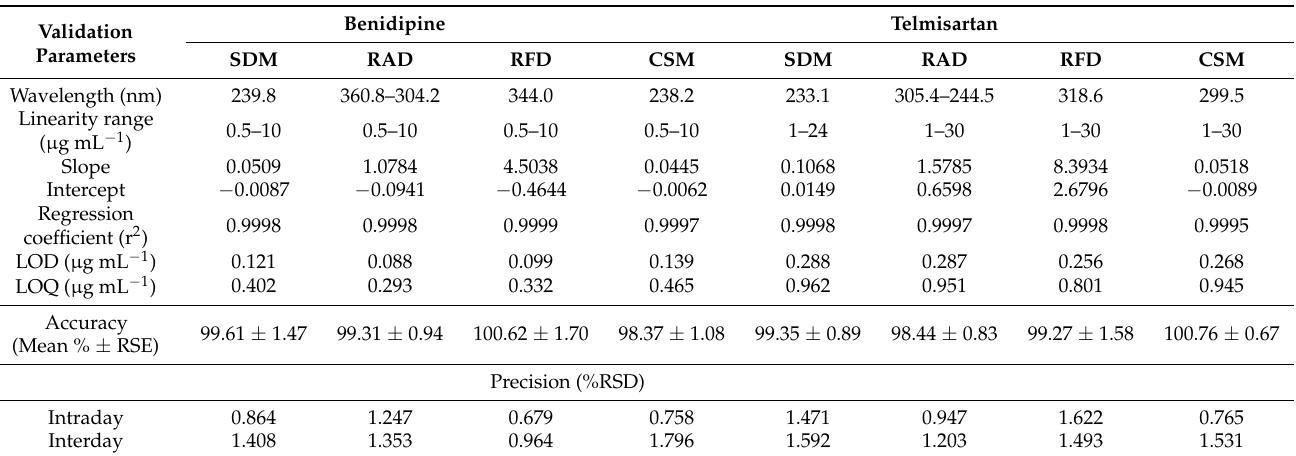
Table 1. Validation parameter results of the proposed spectroscopic methods for the simultaneous determination of BEN and